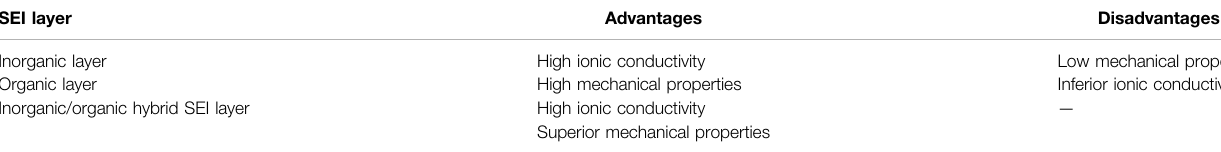
TABLE 1 | Properties of the inorganic, organic, and inorganic/organic hybrid SEI layers. SEI